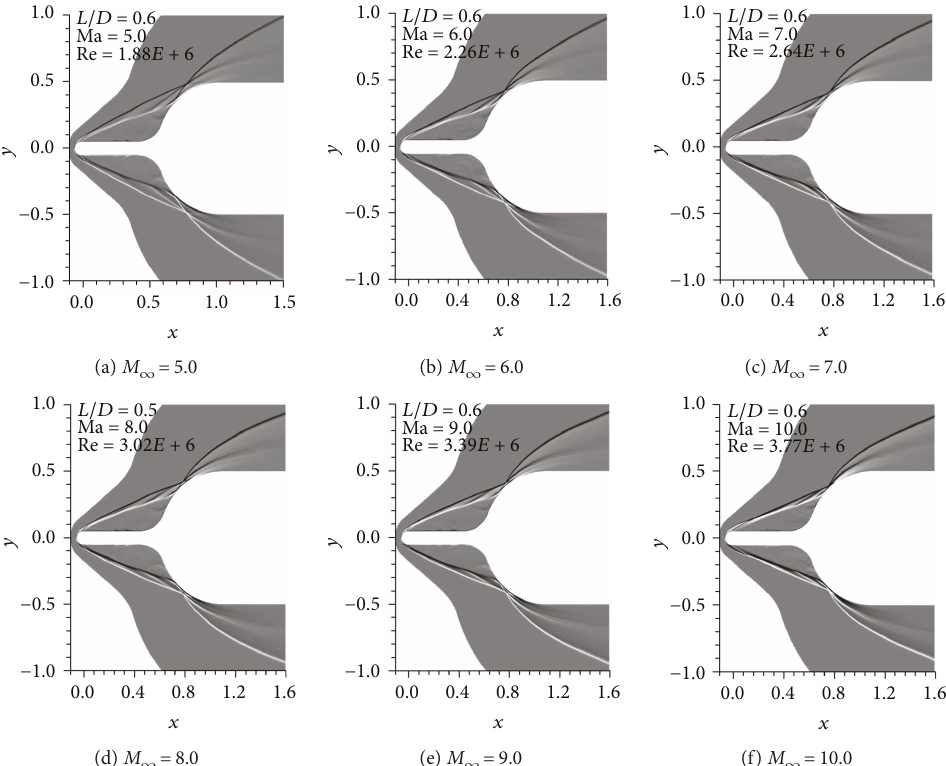
Figure 4: Flow fi eld density gradient in y direction of pure spiked blunt bodies. Spike length L/D =